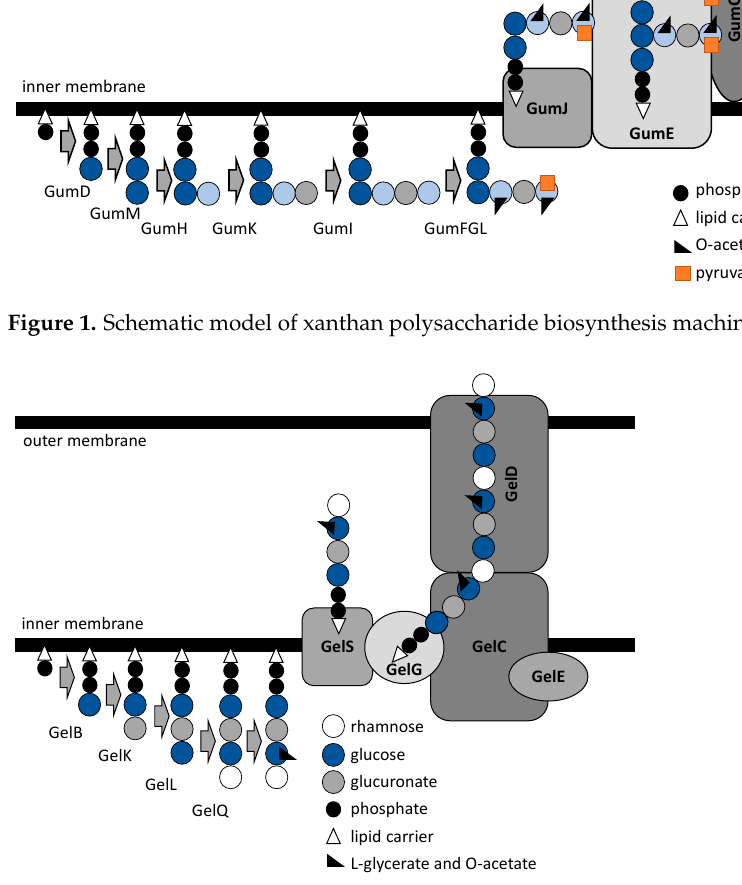
Figure 2. Schematic model of gellan polysaccharide biosynthesis machinery.